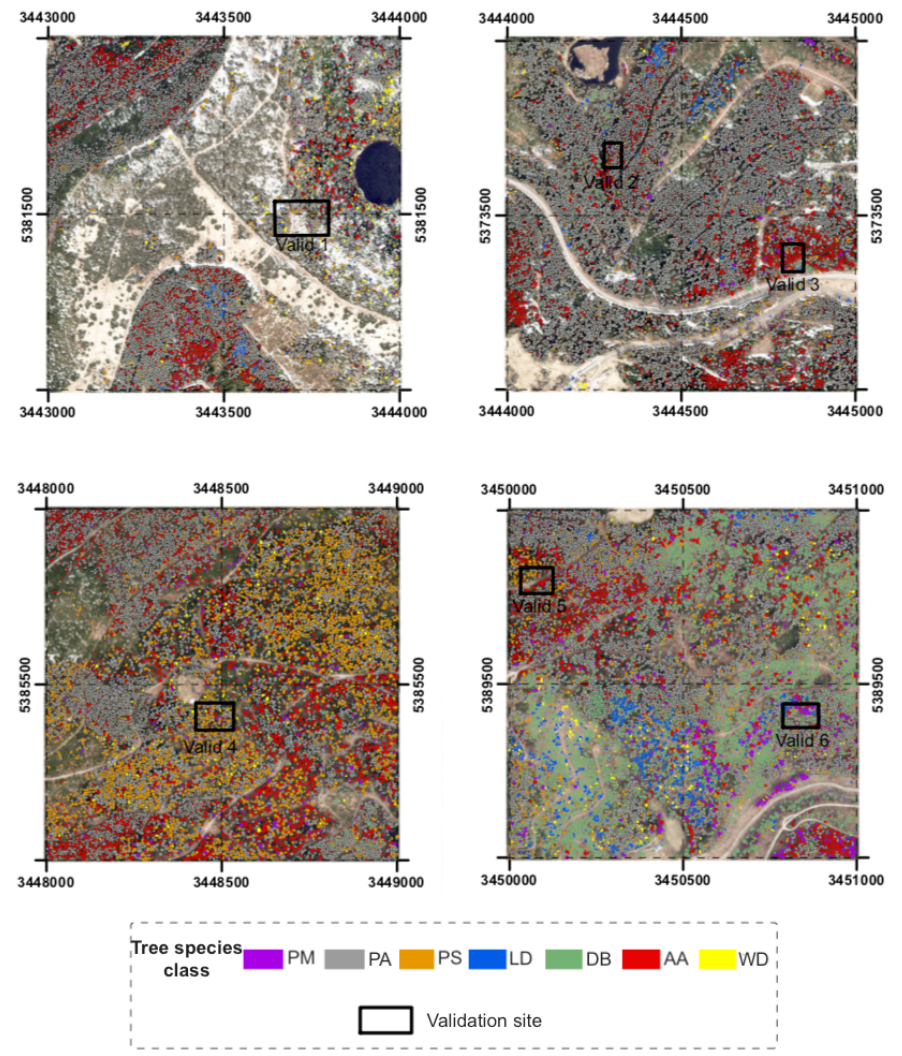
Figure 5. Result maps of classified tree classes in the four test sites and location of the six valida- tion